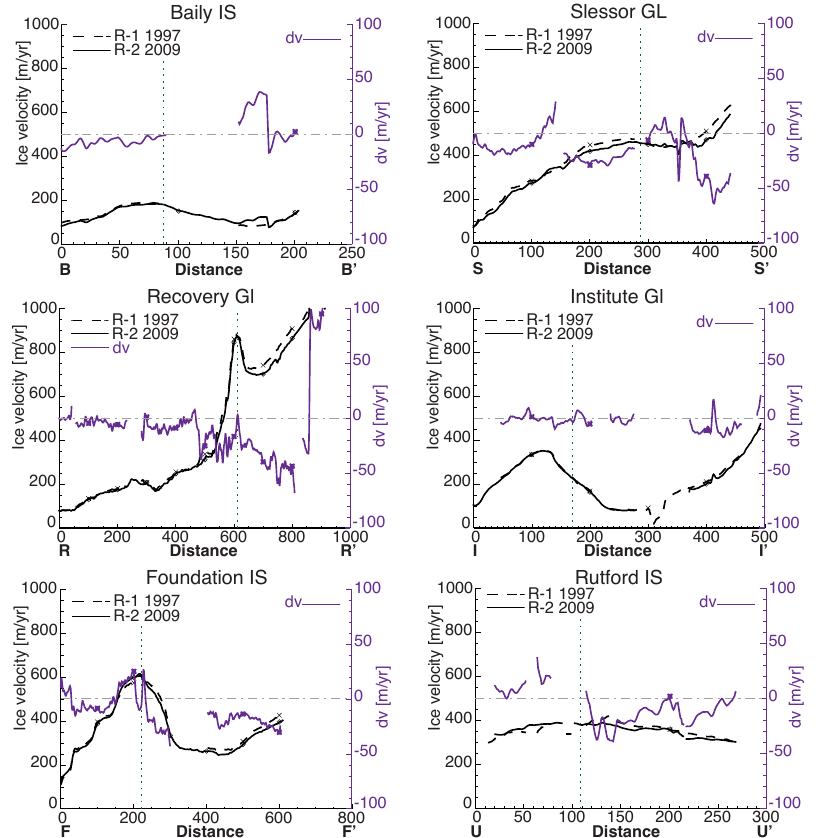
Fig. 5. Flow line plots for Filchner-Ronne Ice Shelf tributaries showing the absolute velocities for 1997 and 2009 and the 12-yr difference in speed d v . Markers set every 100km correspond to the markers shown in Fig. 4. The vertical dashed line is the 2009 grounding